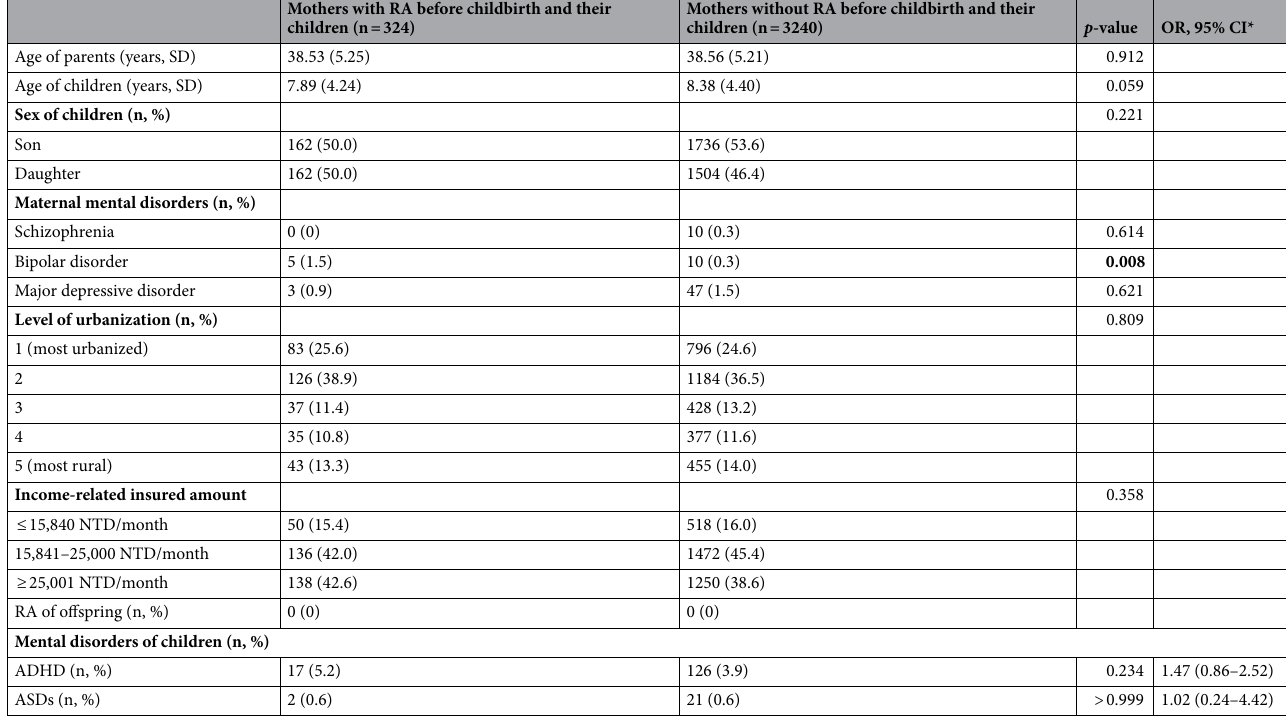
Table 3. Risks of attention-deficit/hyperactivity disorder and autism spectrum disorders among offspring of mothers with rheumatoid arthritis diagnosed before childbirth. Note: bold figures indicate statistical significance. Abbreviations: RA rheumatoid arthritis, OR odds ratio, CI confidence interval, SD standard deviation, NTD new Taiwan dollar, ADHD attention-deficit/hyperactivity disorder , ASDs autism spectrum disorders. *Adjusted for demographic data, offspring RA, and maternal mental